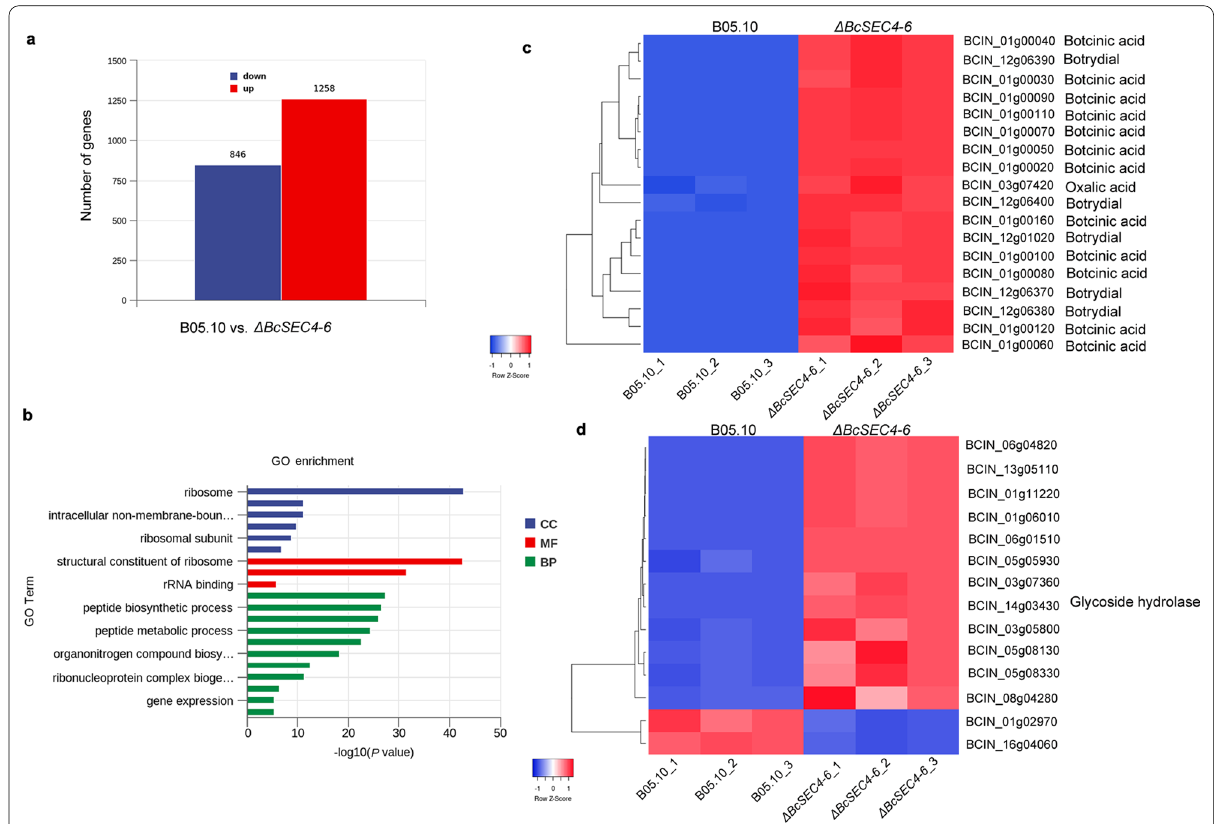
Fig. 8 Comparative transcriptome analysis between B05.10 and the ΔBcSEC4 mutant. a The number of differentially expressed genes. b GO classification analysis of differentially expressed genes between B05.10 and the ΔBcSEC4 mutant. c Genes related to secondary metabolism. d Membrane‑associated genes. Colors indicate differentially expressed genes (RNA‑Seq): blue for downregulation and red for